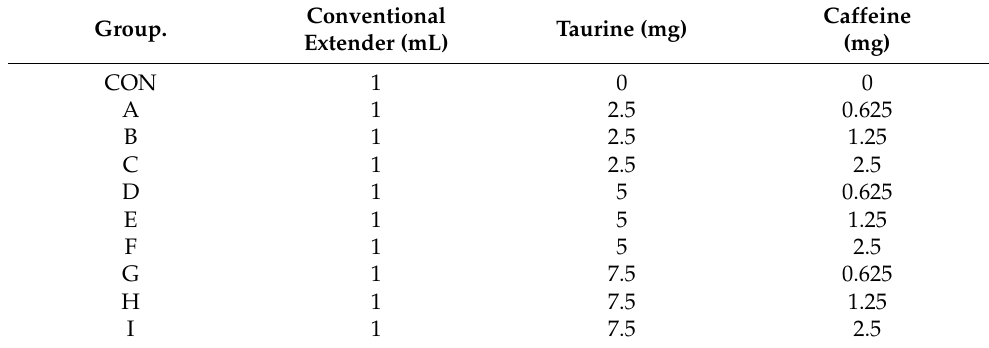
Table 1. Concentrations of taurine and caffeine used in the study.